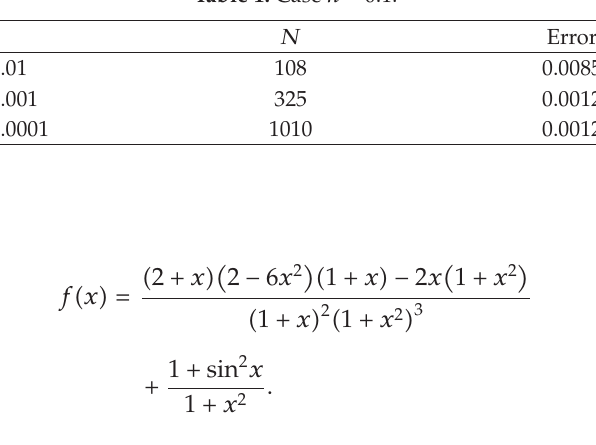
Figure 1: Exact versus approx. solution. Table 1: Case h (cid:8) 0 .